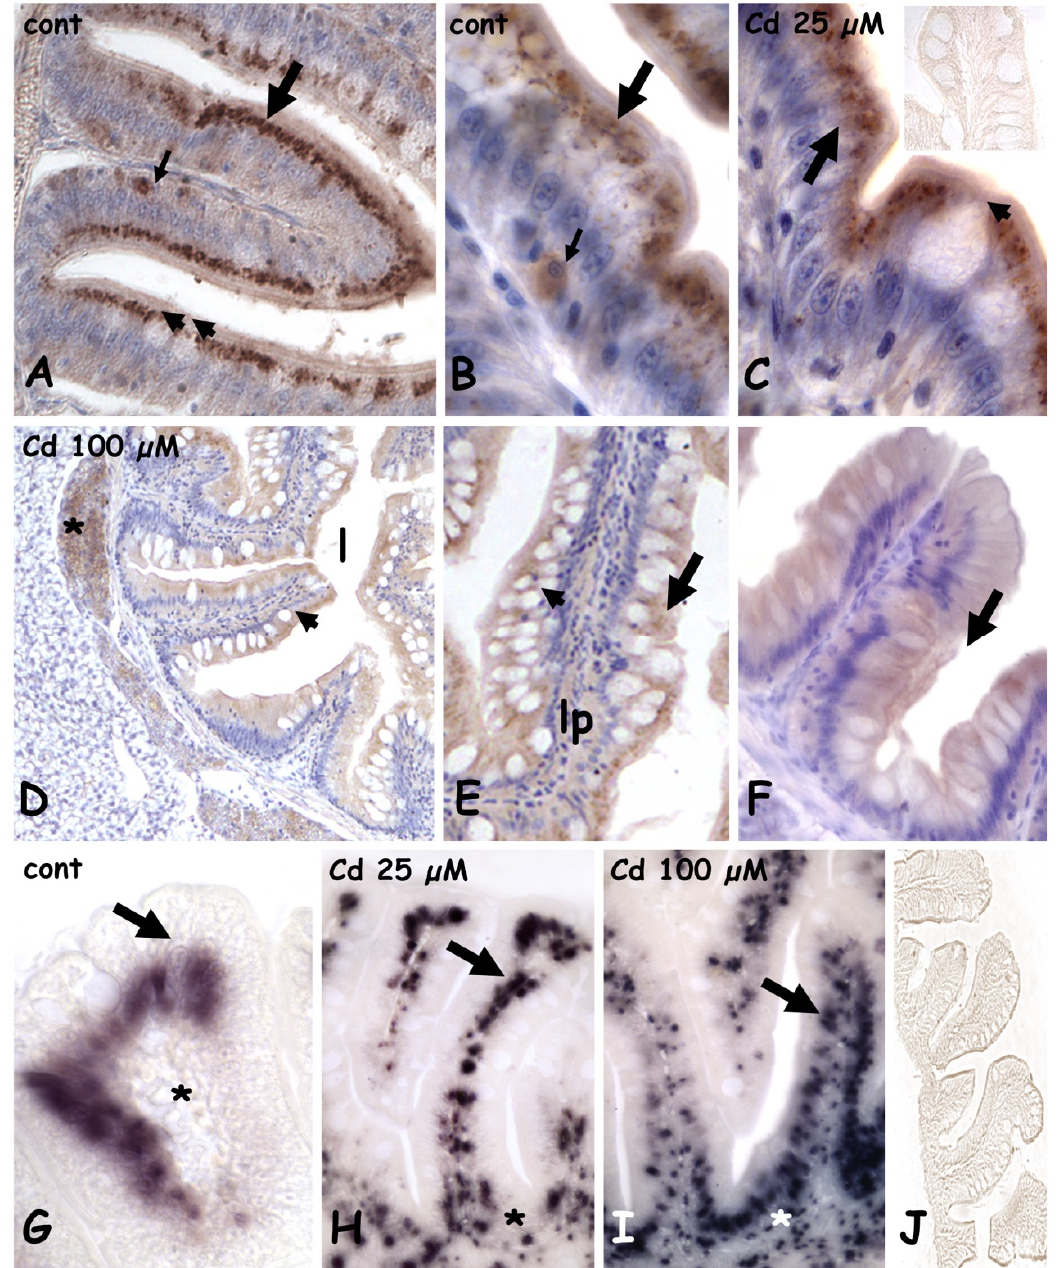
Figure 3. Metallothionein ( A – F ) and metallothionein mRNA ( G – J ) localization in the anterior and mid intestine in Danio rerio exposed to cadmium. ( A – C ) anterior gut; MT is in the apical cytoplasm of enterocytes (large arrow) and in occasional cells located close to the lamina propria (small arrow). Goblet cells are unstained (arrowheads). Anterior gut ( D , E ) and mid ( F ) gut; MT is uniformly dispersed in the cytoplasm of enterocytes (arrow). Goblet cells (arrowheads) are unstained. Lamina propria (lp), positive pancreatic cells (*). Inset in ( C ): negative control of immunocytochemistry. ( G ) anterior gut; MT mRNA is in enterocytes nuclei (arrow). Lamina propria is unstained (*). ( H – I ) anterior gut; dose-dependent increase in labeled submucosa and lamina propria nuclei (arrows). ( J ) Negative control of in situ hybridization. Hemalum counterstaining ( A – F ).